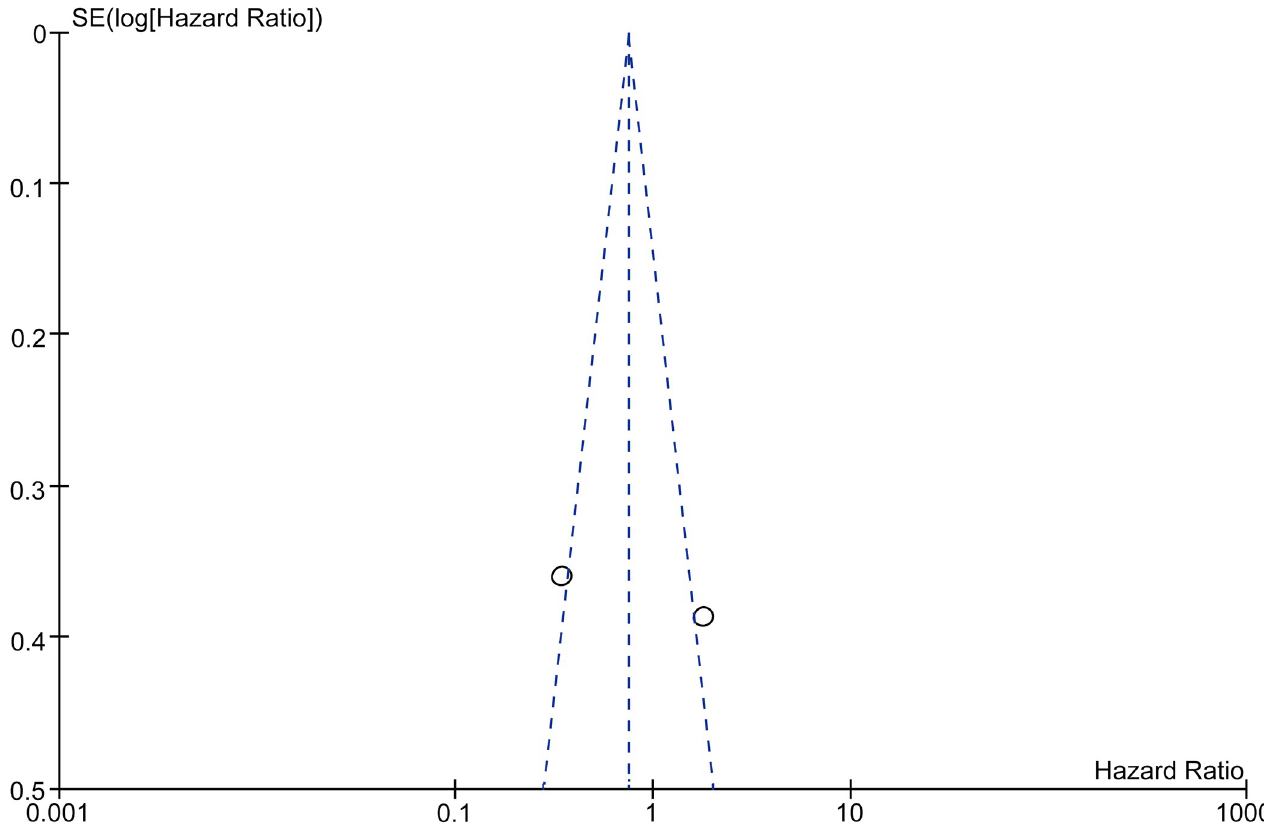
Fig 6. Funnel plot showing disease-free survival as the evaluation